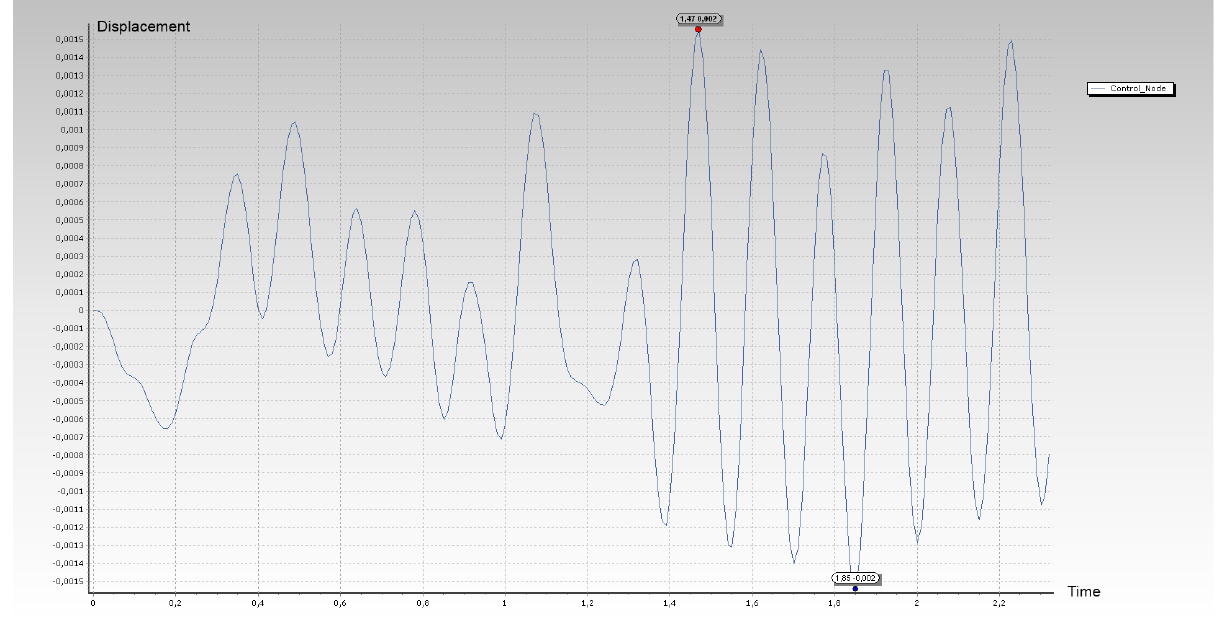
Figure 12. Example of the time-chart of the displacement.